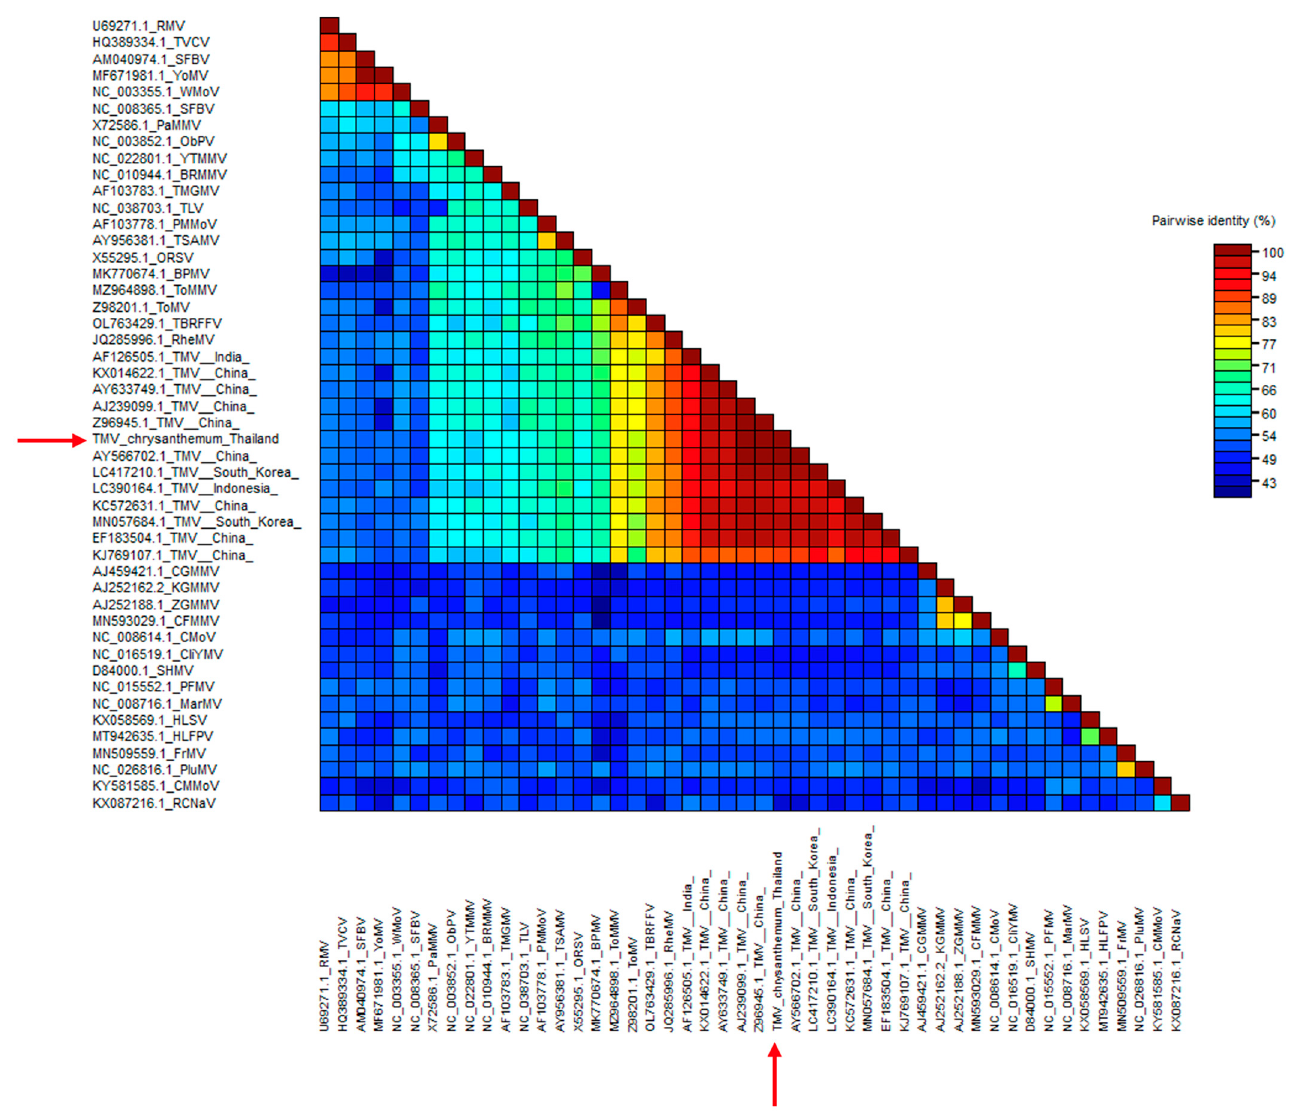
Figure 2. SDT color-coded pairwise identity matrix and phylogenetic tree analysis of TMV CP gene generated from 48 viral sequences comprising 13 TMV sequences and 35 tobamovirus sequences. Color-coded pairwise identity matrix of the Thai chrysanthemum TMV isolate (red arrows). We constructed the pairwise identity matrix using SDT program version 1.2. The cell color indicates the percentage identity score between the two sequences (listed on left and bottom axes) according to the key on the right.